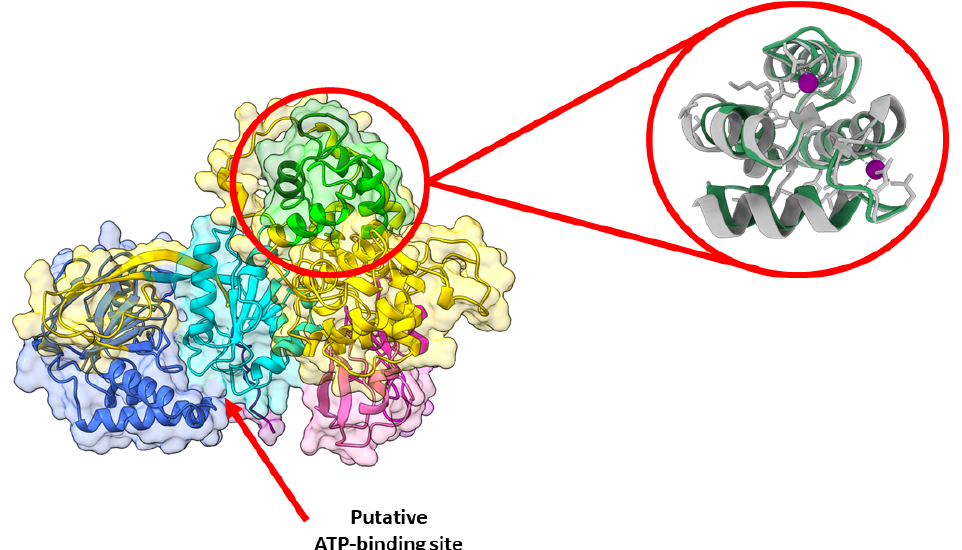
Figure 3. DGK α predicted structure is likely the active one. AlphaFold predicted high-resolution structure of human DGK α (UniprotKB accession number P23743). Structures were generated using Chimera X and domains colored as follows: EF hand 1 (residues 114–142, lime), EF hand 2 (residues 159–187, forest green), C1A (residues 206–253, hot pink), C1B (residues 268–319, magenta), catalytic (residues 376–500, dark turquoise), accessory (residues 520–701, royal blue), and Pro (residues 722–735, purple). The remaining protein was colored in gold. Enlarged on the right panel is the overlay between the predicted (green) and the experimentally solved (gray, PDB ID: 6IIE [32]) structures of the EF hand domains. The experimentally solved structure had Ca 2+ bound, which is shown in purple. The red arrow indicates the putative ATP ‐ binding site is exposed in the predicted structure.